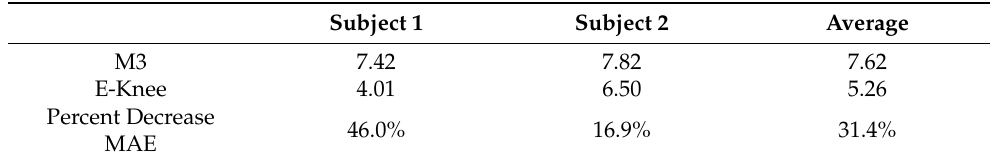
Table 4. Mean absolute error (MAE) of vertical GRF when compared to the C-Leg. Percent decrease highlights improvement from M3 to